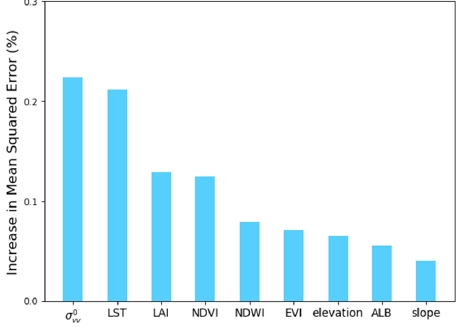
Figure 3. The variable importance scores.